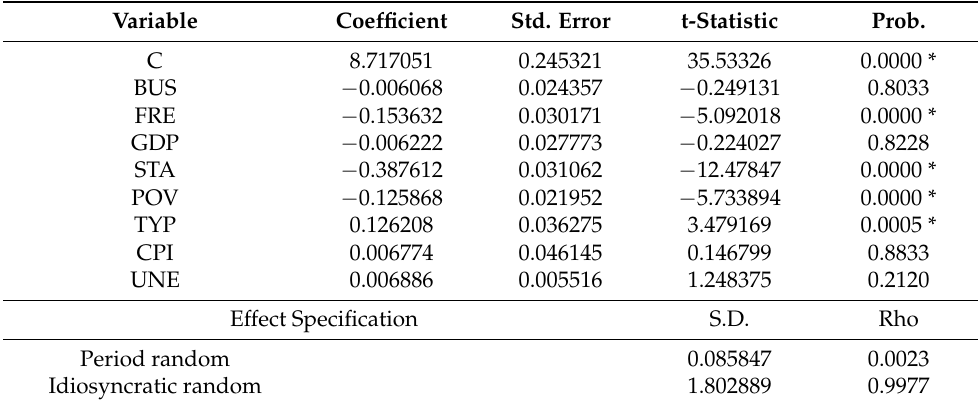
Table 4. Random effect model—panel EGLS (period random).